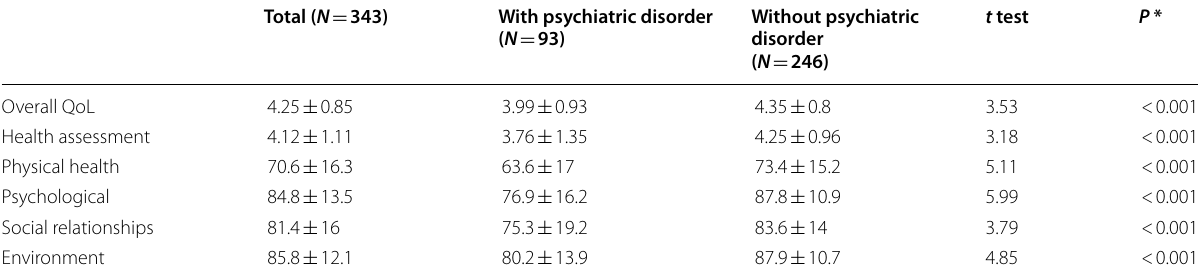
*Independent sample t test was used between cardiac patients with psychiatric disorders vs. cardiac patients without psychiatric